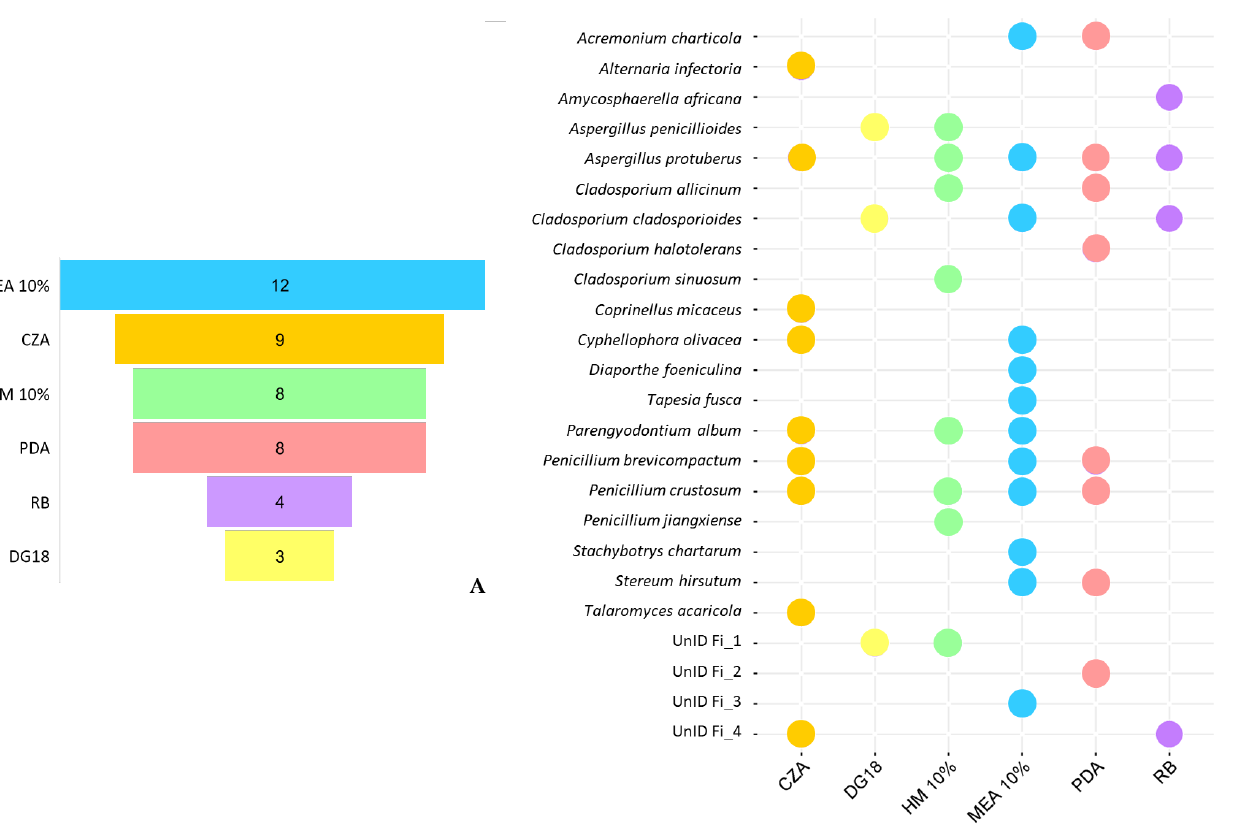
Figure 7. Differences in fungal isolates retrieved from the different culture media used for fungal isolation in this study. ( A ) The number of unique taxa isolated from each medium. ( B ) Overlap of cultivable species among the different culture media.